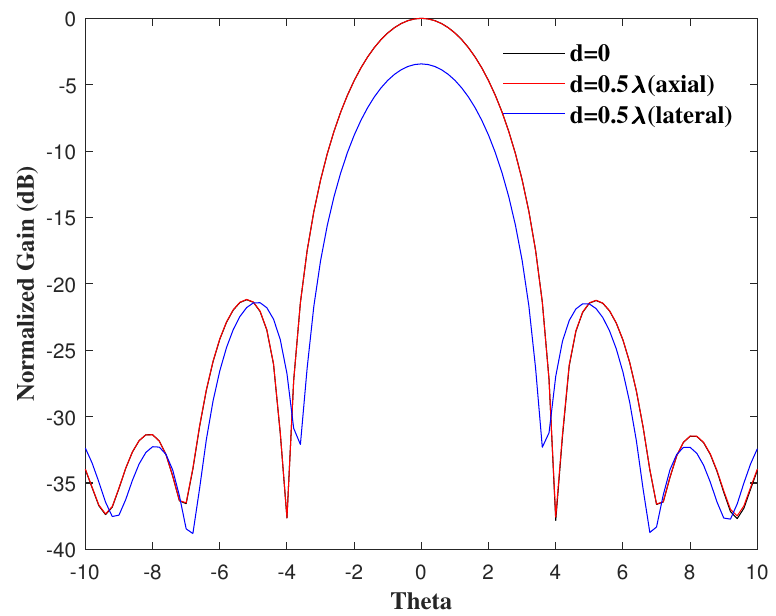
Figure 5. Far-field pattern of d = 0,0.5 λ (axial) and λ (lateral).